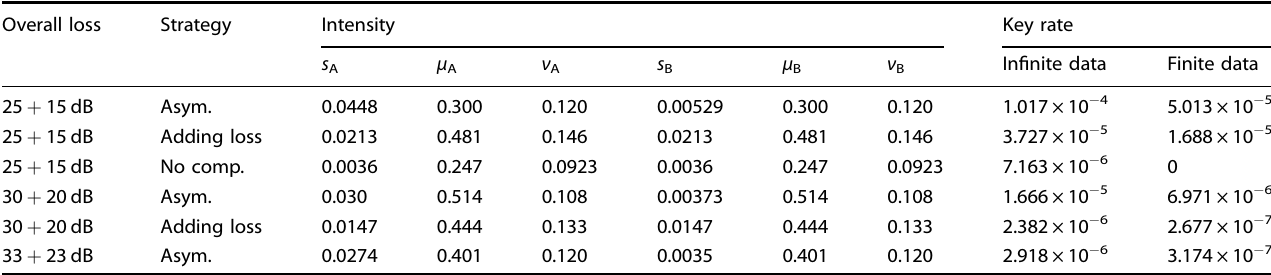
Table 1. List of intensity sets and experimental secret key rates for the overall system losses of 40 dB, 50 dB, and 56